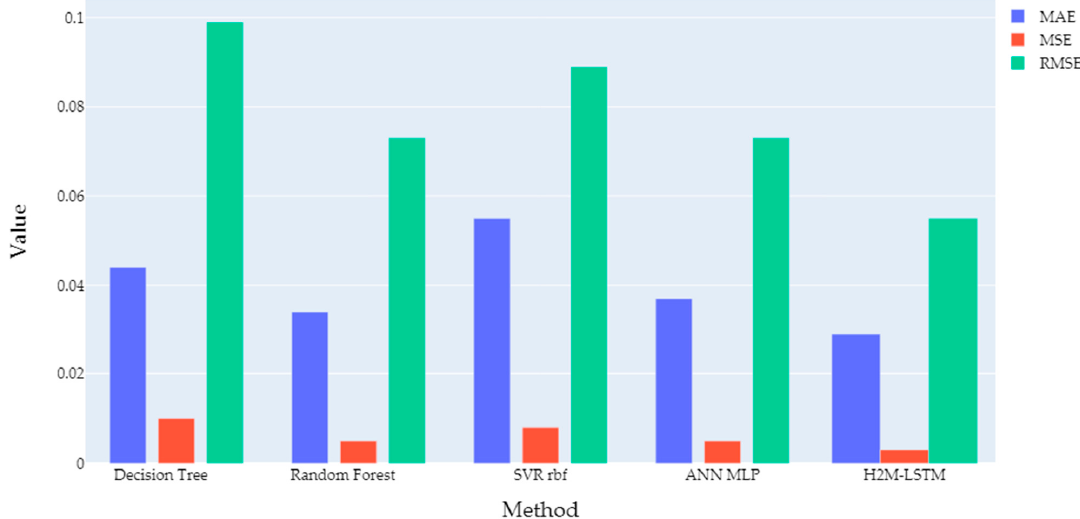
Figure 15. Barplot comparison of the best performance metrics for the cascading architecture. The proposed hybrid bimodal LSTM architecture (H2M-LSTM) exhibits robust per- formance and consistent behaviour in the cascading modelling approach as well, achiev- ing the lowest values in all performance metrics. It is noteworthy to mention that its per- formance is almost identical to the performance of the individual modelling of the heat storage tank . In detail, H2M-LSTM achieved 0.029 MAE, 0.003 MSE and 0.055 RMSE, sur- passing the RF in MAE by 0.005 and the RF and the ANN in MSE and RMSE by 0.002 and 0.018, respectively. As it is observed from, DT, BT, and SVR(rbf) achieved moderate per- formances which are within the same order of magnitude of the RF and ANN, but still less accurate than the H2M-LSTM. The comparative analysis between the individual com- ponent modelling of the heat tank and the cascading model resulted in differences less than 10 − 4 for the MSE and MAE that were therefore considered as insignificant. This small observed deviation demonstrates that the proposed cascading model works with almost the same accuracy as with the model that was individually trained with the real input- output tank data. The visual representation of the heat storage tank model’s output values, under the cascading implementation with the hybrid bimodal LSTM model is presented in Figure 16, for the 6 January 2015. The real temperature output is shown in green (a), the predicted in blue (b) and the absolute difference (AD) in orange, unless it surpasses the 5 °C limit where it turns red (c).